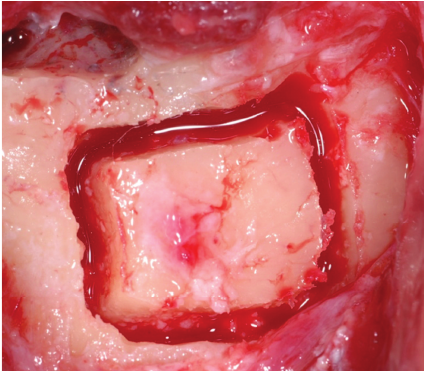
Figure 5: Harvesting procedure of a corticocancellous bone block in the mandibular symphysis.